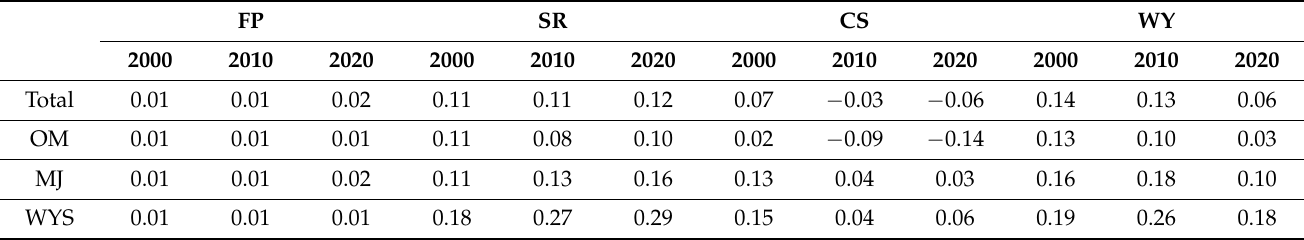
Table 6. The mean values of ecosystem services supply-demand ratios. FP SR CS